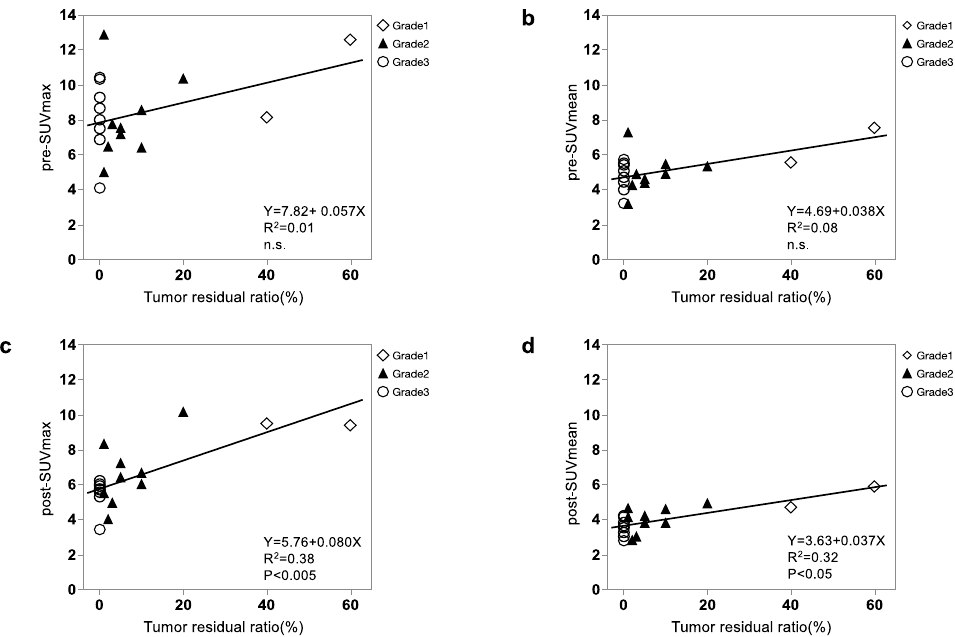
Figure 3. Correlation between residual tumor rate and PET imaging parameters of MET uptake. There was a positive linear relationship between the residual tumor rate and all the parameters. ( a ) pre-SUVmax. ( b ) pre- SUVmean. ( c ) post-SUVmax. ( d ) post-SUVmean. Spearman’s test was used for the statistical